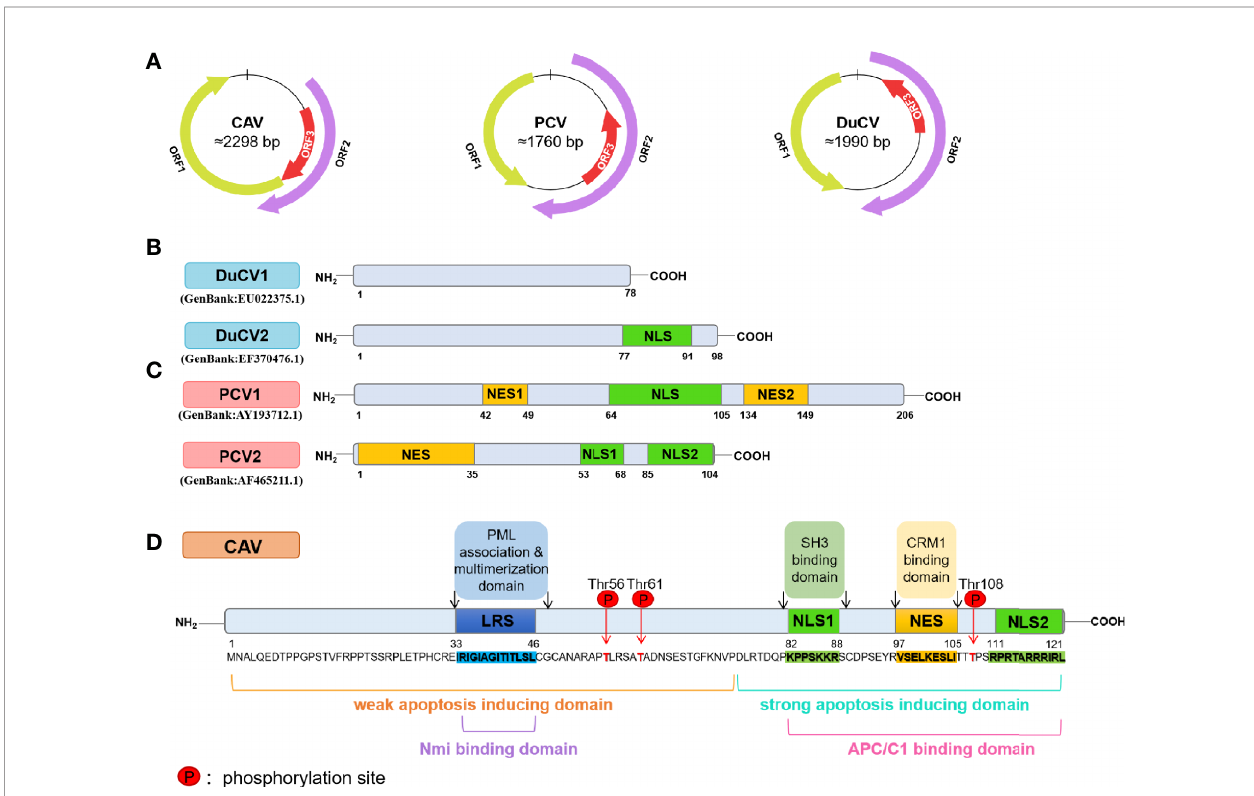
FIGURE 1 | Schematic diagram of the CAV, PCV and DuCV gene structures. (A) The relative localizations of three major ORF proteins in CAV, PCV, and DuCV differ from each other. In particular, the ORF3 proteins of PCV and DuCV are oriented in the direction opposite that of Rep gene, in contrast to the ORF3 protein in CAV. (B) The ORF3 protein structures between DuCV1 and DuCV2 differ. The DuCV2 ORF3 (99 aa) is 20 aa longer than that of DuCV 1, in which an NLS has been identi fi ed. (C) The ORF3 structures between PCV1 and PCV2 differ. The length of the ORF3 is 315 bp in PCV2, while in PCV1, it is approximately 612 bp. The NES has been identi fi ed in the N-terminus of PCV2 ORF3 protein at residues 1 – 35, and a bipartite NLS was found at residues 53 – 68 and 85 – 104. (D) The primary structures of the CAV ORF3 protein (Los et al., 2009). The following main domains are shown in color: leucine-rich region ( blue ), phosphorylation site ( red ), bipartite nuclear localization sequences ( green ), and nuclear export sequence ( yellow